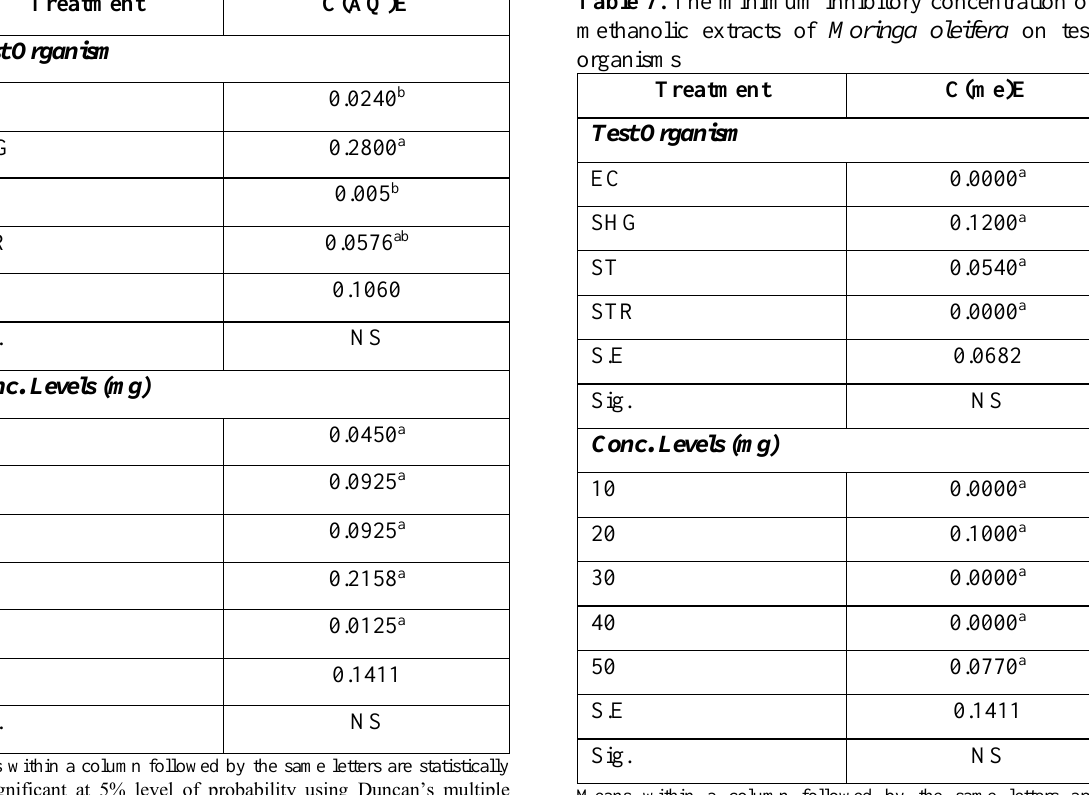
Table 7. The minimum inhibitory concentration